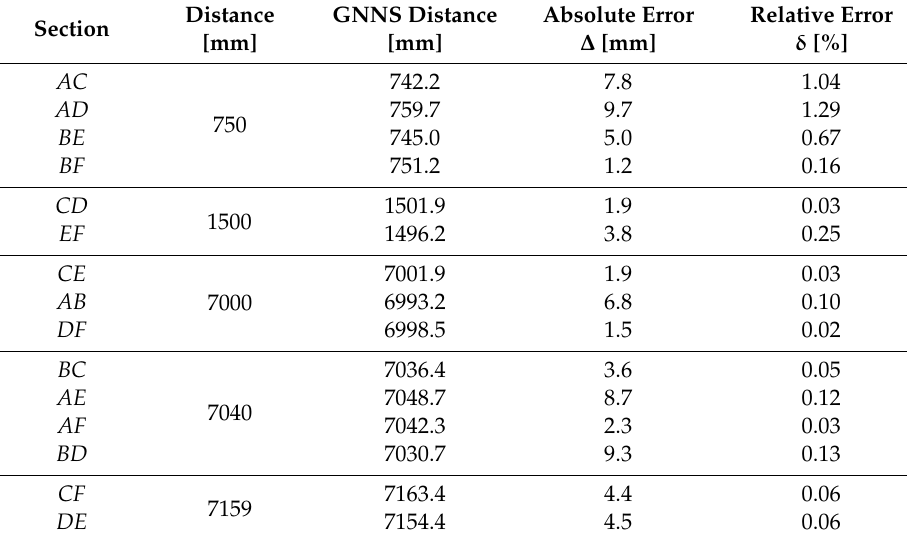
Table 2. Measured distances between receivers and their